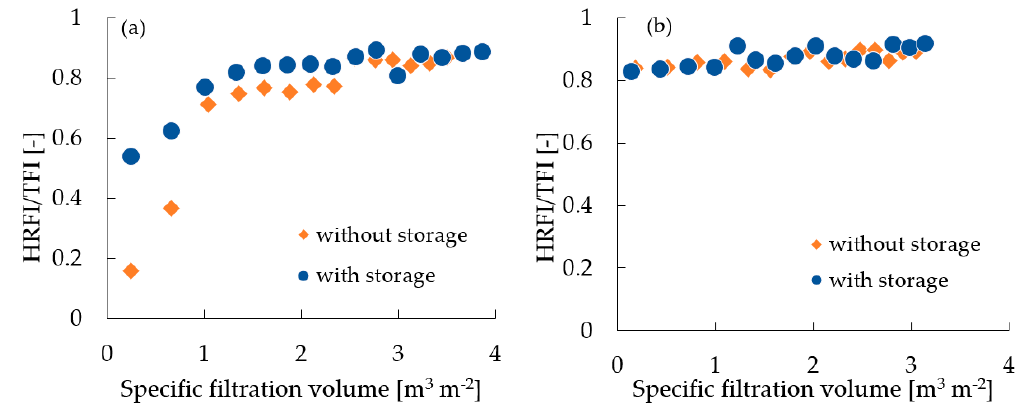
Figure 7. Ratio of hydraulically reversible fouling index (HRFI) to total fouling index (TFI) through the operation in ( a ) November 2014 and ( b )March 2015.